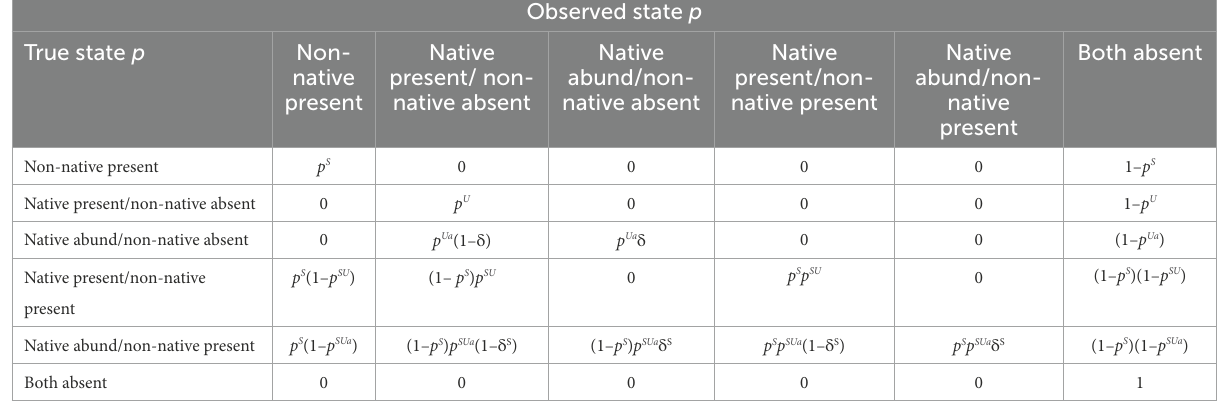
TABLE 1 Conditional detection probability matrix for the true state given (/) the observed state for the 2SMS occupancy